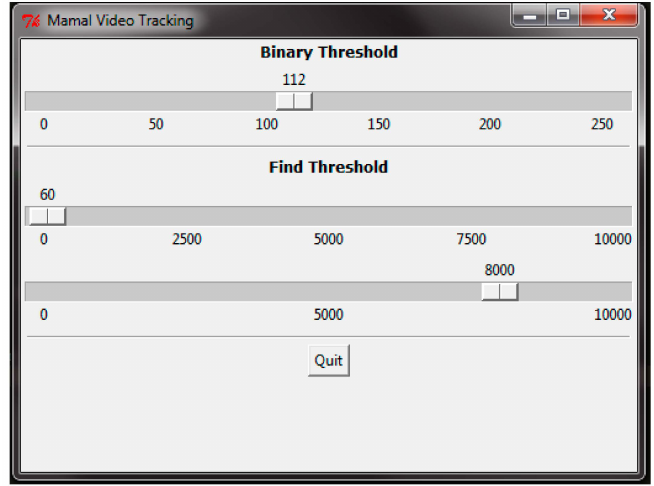
Figure 5. Graphical user interface (GUI) of the intensity threshold algorithm which allows the end user to adjust the thresholds using the sliders.